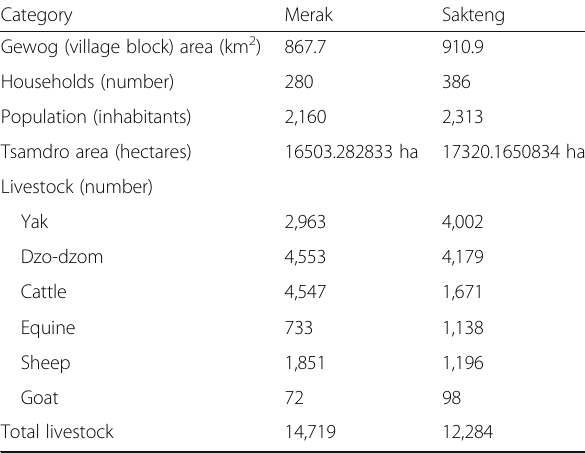
Table 1 Basic statistic and livestock population of Merak and